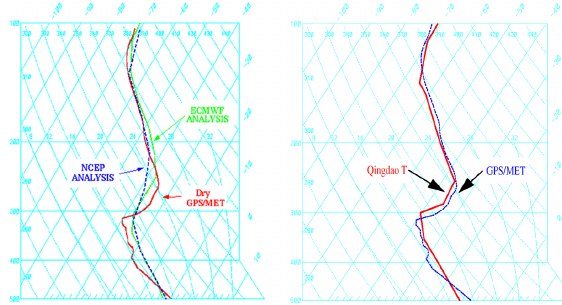
Fig. 18. A GPS/MET sounding through an upper-level front 00:55UTC 22 October 1995 over China compared to soundings from NCEP and ECMWF (left panel) and a nearby radiosonde at Qingdao (right panel) (Kuo et al.,